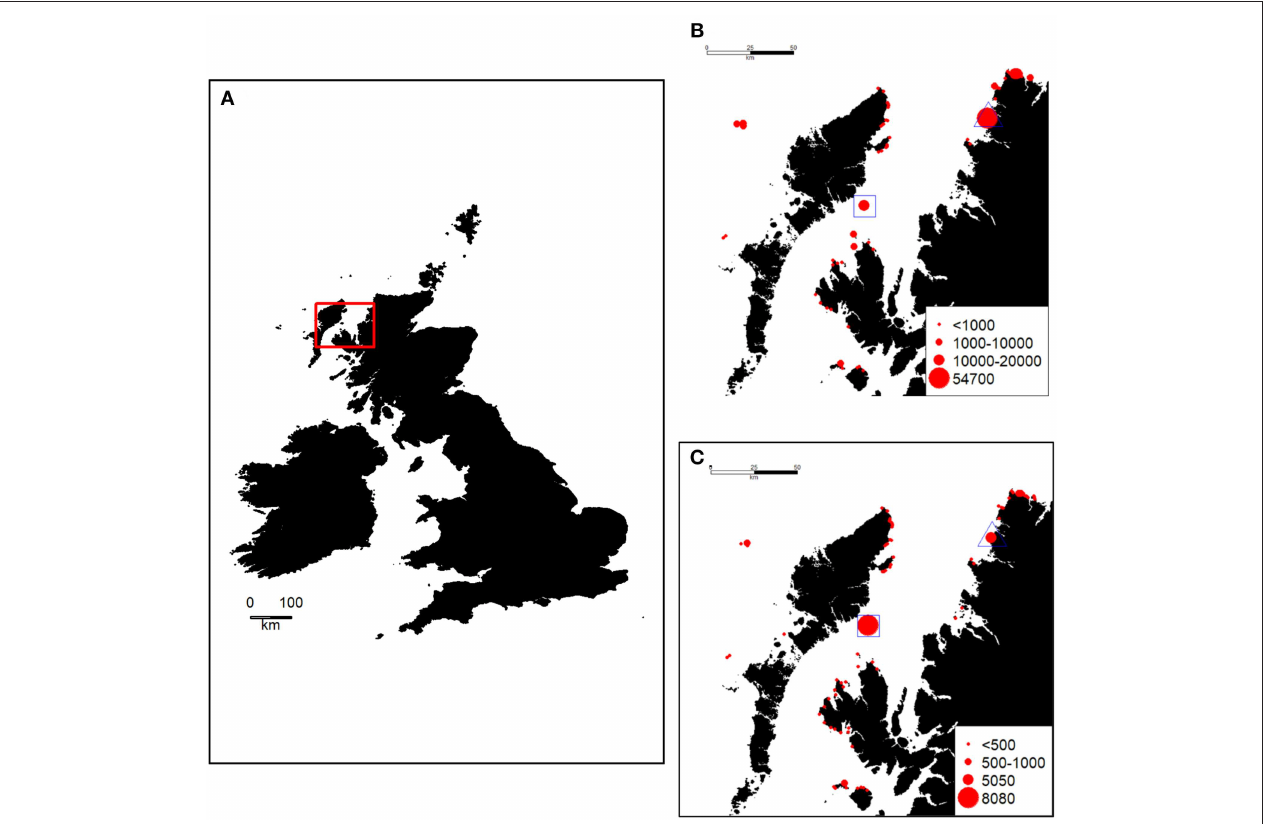
FIGURE 1 | (A) Location of the study area (red box) in the British Isles, size of Guillemot (B) and Razorbill (C) colonies in and around the study area [estimated number of individuals, from the Seabird Monitoring Programme Database www.jncc.gov.uk/smp ( Mitchell et al., 2004). During the study, these species were GPS-tracked from a colony on the Shiants (blue square). At the same time, a boat-based survey was undertaken throughout the study area as shown in Figure 3 . The location of Handa Island is indicated by a blue triangle.